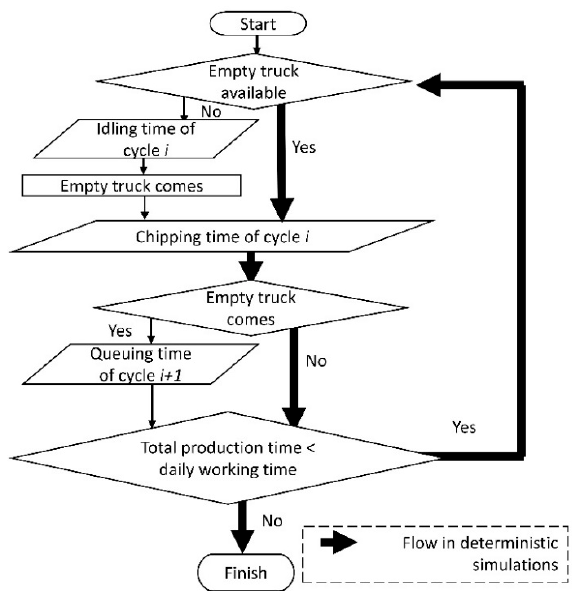
Figure 1. Flowchart of a daily chipping simulation. The flow in bold arrow is the flow in deterministic